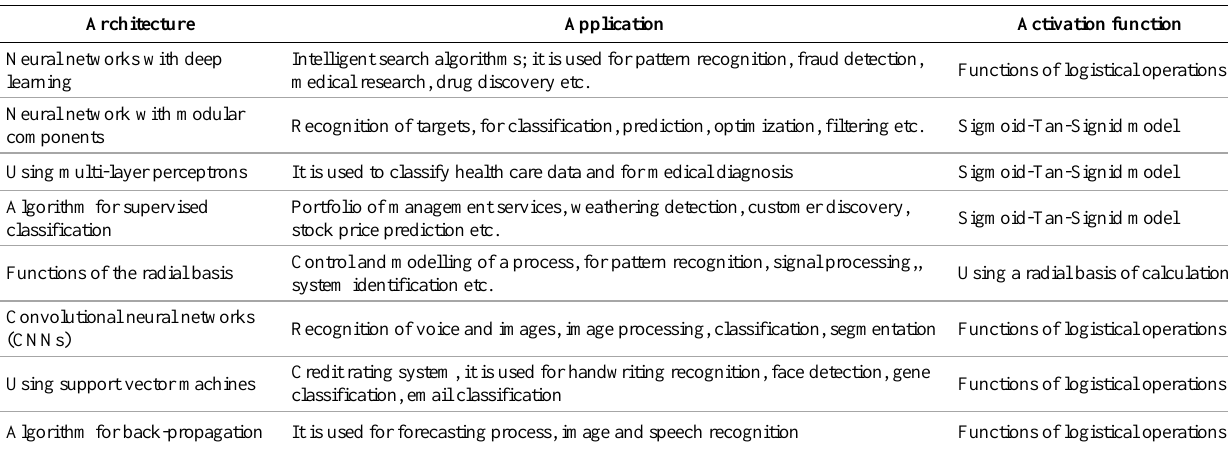
Table 2. Neural Networks and Their Applications